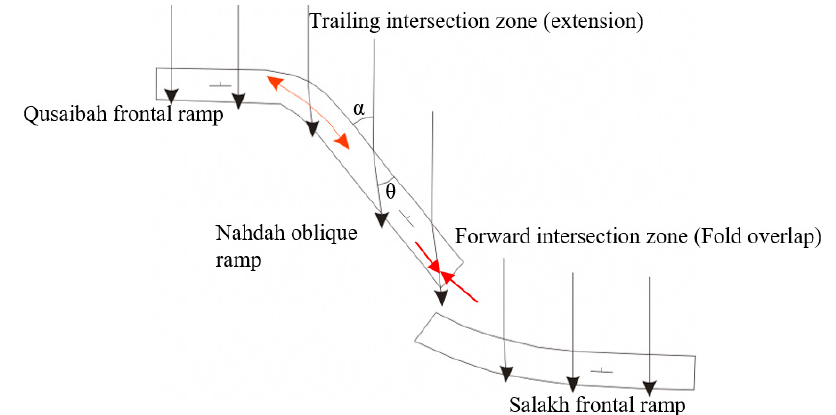
Figure 19. A simple map-view illustration of the divergence of hangingwall materials as they move through the Nahdah’s oblique ramp ( α = θ ) (insight from Apotria’s model [25,37]. The arrows represent the transport directions. Arc-parallel extension developed between the Qusaibah and Nahdah structures and arc-parallel shortening or overlap formed between the Nahdah and Salakh structures.